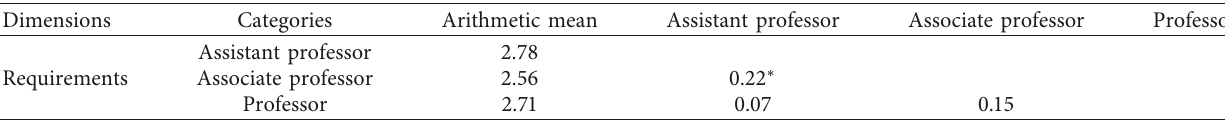
Table 12: Dimensional comparisons using (Scheff´e’s test) for the impact of the scientific rank on the requirements, obstacles, and proposed solutions to overcome distance education obstacles in the face of university educational crises.